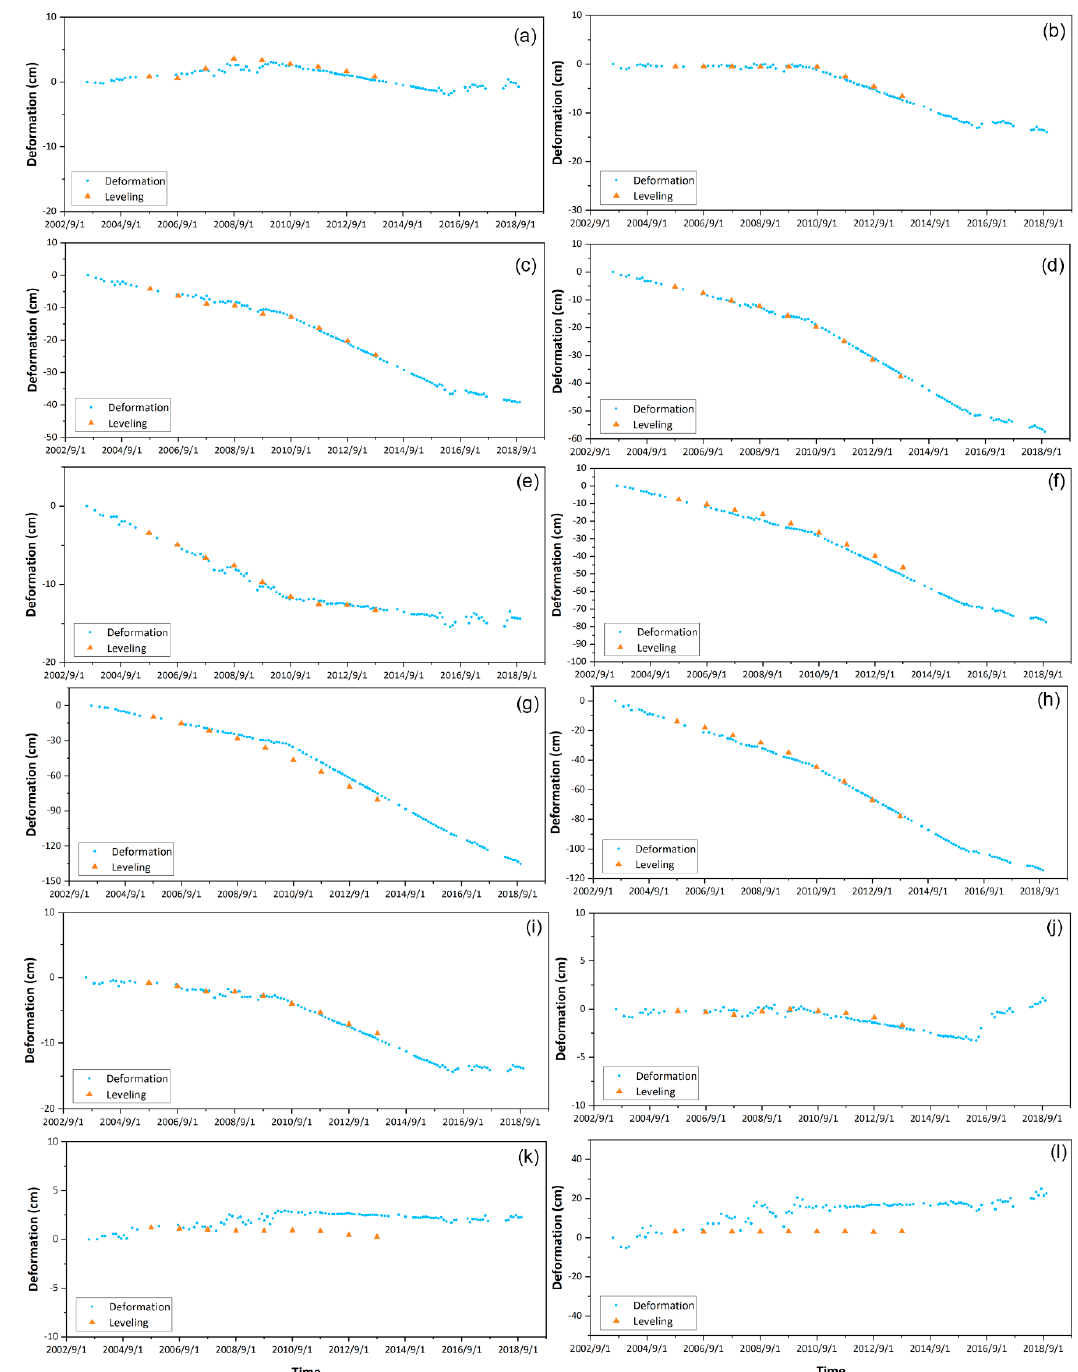
Figure 9. Time-series matching diagram of leveling and MMTI-TSF results (Part 1). The position of the benchmark is shown in Figure 8c.